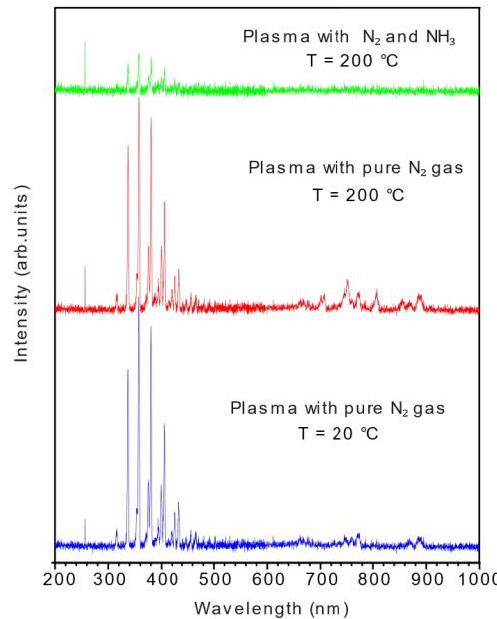
Figure 3. Spectra of nitrogen plasma at 20 °C (blue line) and 200 °C (red line). The top graph (green line) shows the plasma spectrum at 200 °C when ammonia gas was added to the nitrogen.